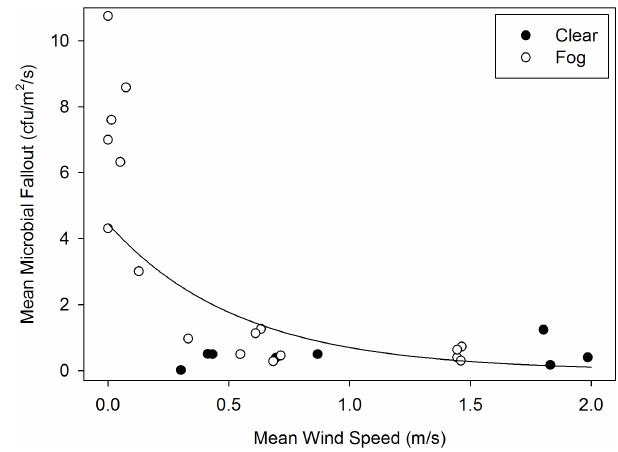
Fig. 1. Mean aerosol particle size ( D p , µm) plotted against mean wind speed (ms − 1 ) during microbial aerosol sampling events under clear and foggy conditions, coastal Maine, USA. Solid curves indi- cate linear regression models. Under foggy conditions, R 2 = 0 . 77